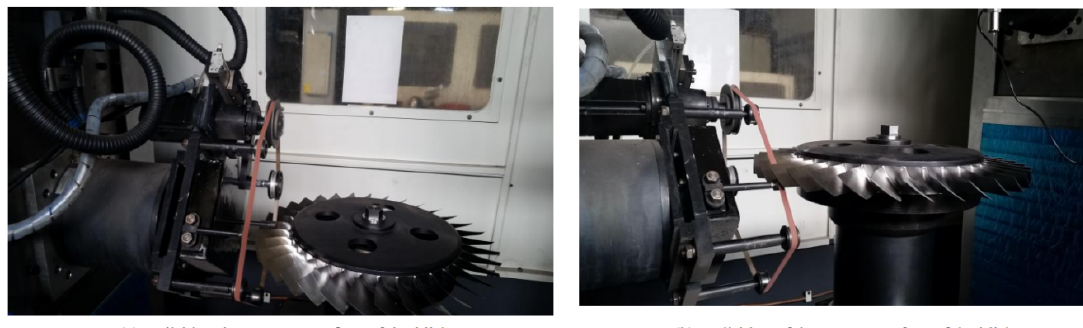
Figure 17. Polishing experiment of the